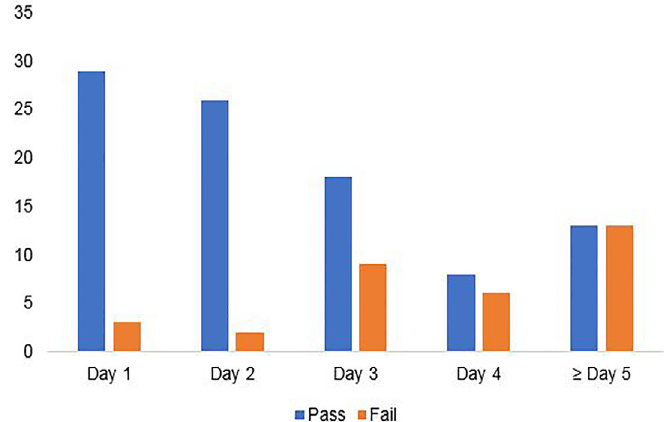
Figure 2. Graphical analysis of mask failure rates as a function of mask age, demonstrating a drop-off in mask pass rates beyond day